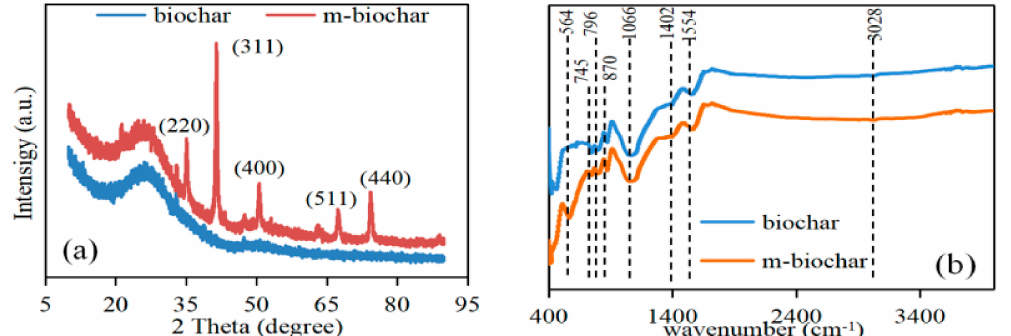
Figure 1. XRD ( a ) and FTIR ( b ) patterns of the pristine biochar and m-biochar.